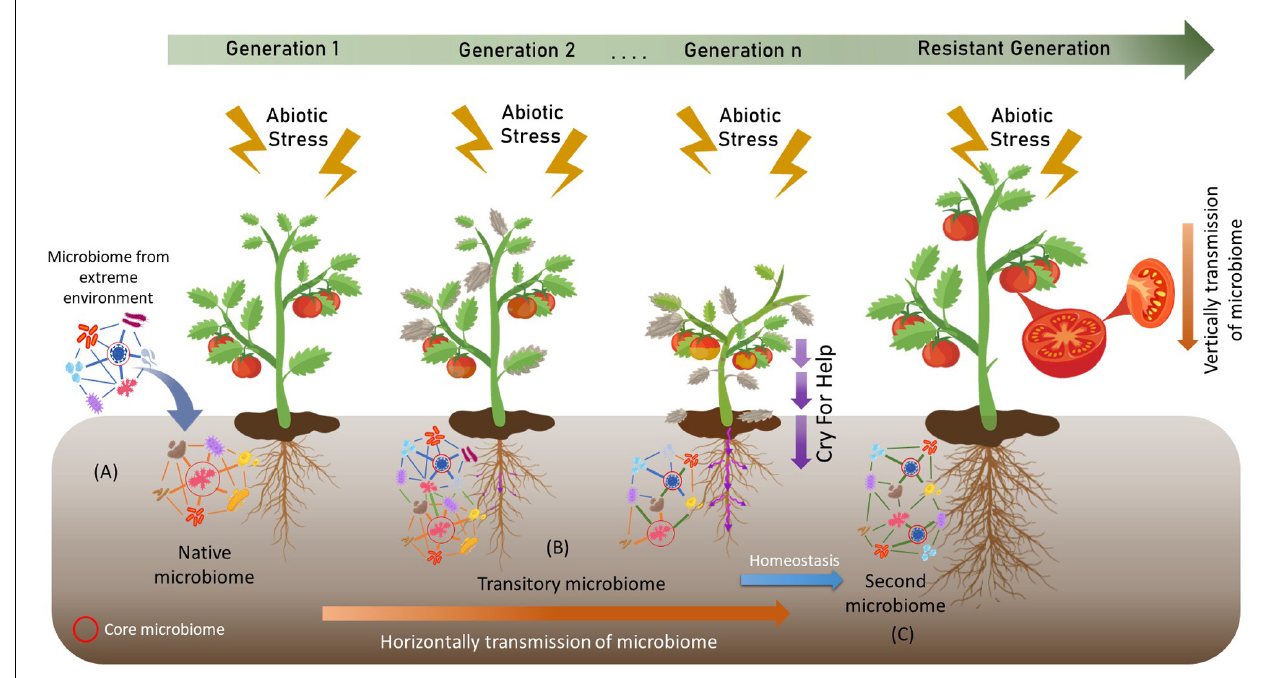
FIGURE 2 | Artificial selection of microbiomes by host-mediated and multigenerational selection. (A) The incorporation of an extreme microbiome modifies the native microbiome. (B) This new transitory microbiome is transmitted horizontally through the soil and undergoes alterations through the processes of Cry For Help. (C) After time, the microbiome reach homeostasis forming a second microbiome that helps to alleviate the negative effects of climate